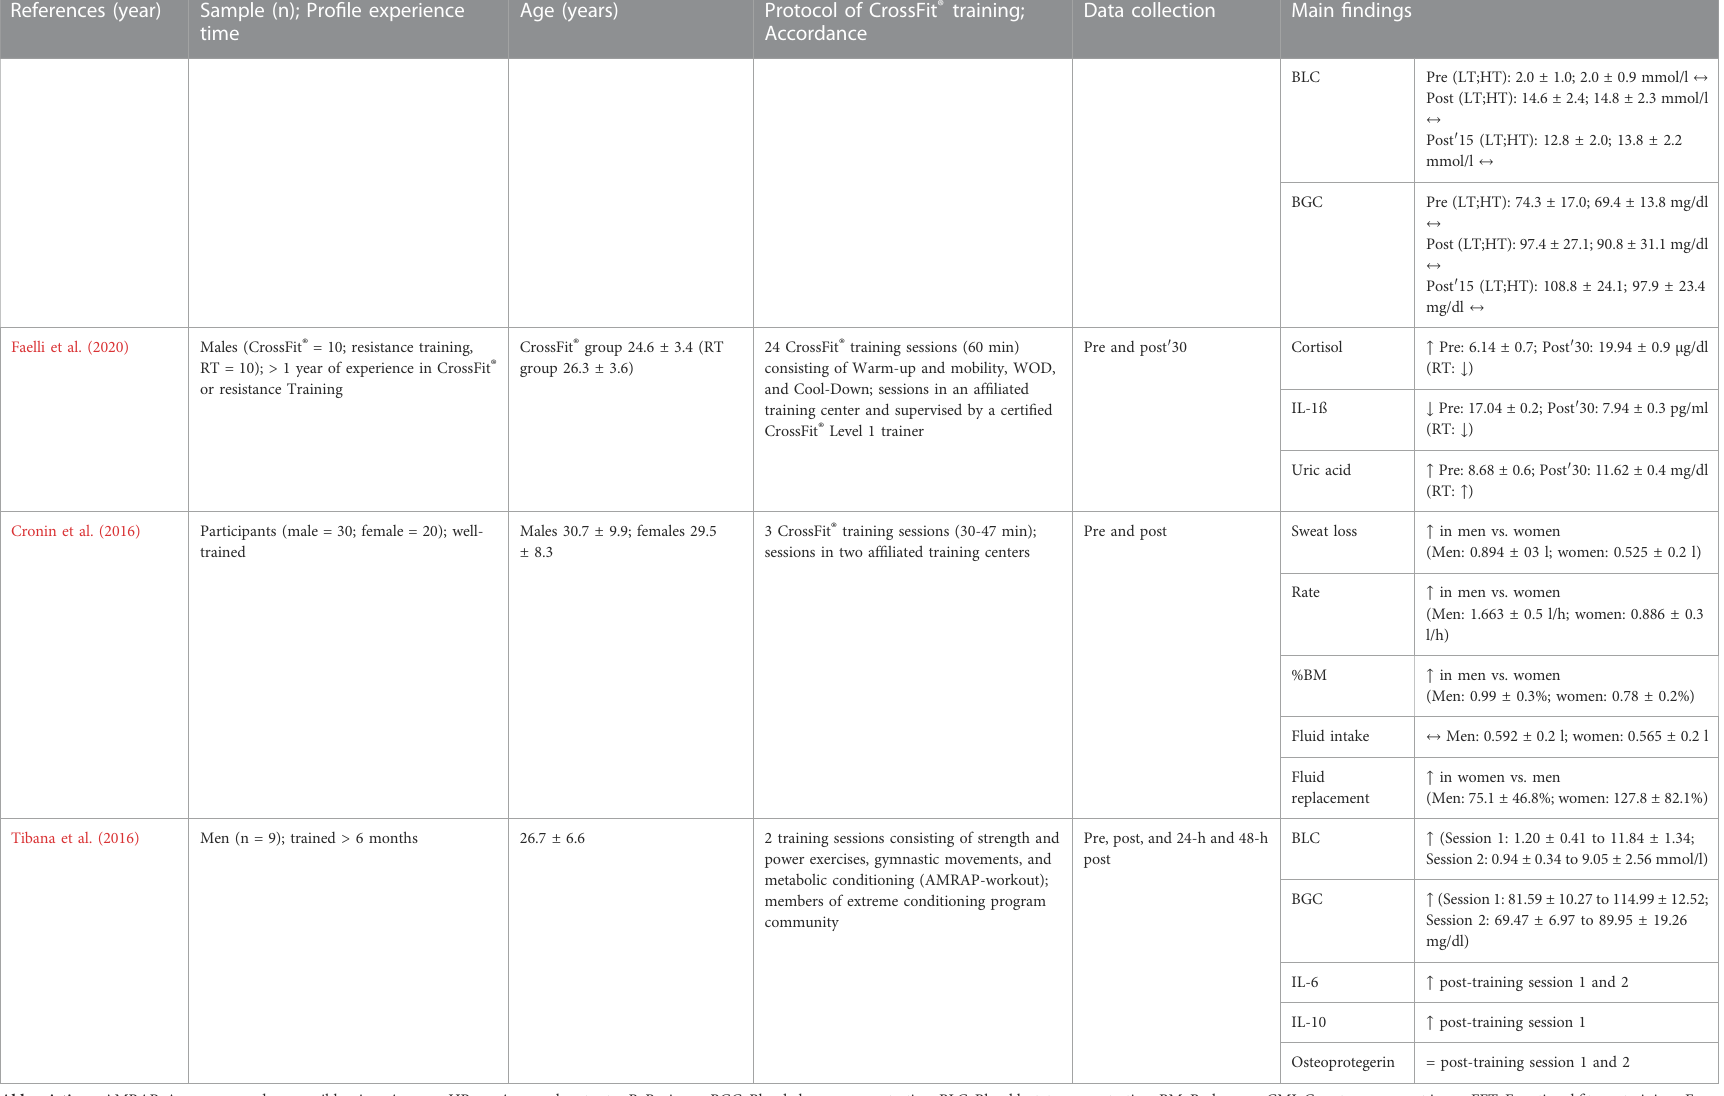
Abbreviations: AMRAP,As manyrounds as possible; Avg, Average; HRavg, Averageheart rate ; B, Beginner; BGC, Bloodglucoseconcentration; BLC,Blood lactate concentration; BM,Body mass; CMJ,Countermovement jump; FFT,Functional fi tnesstraining ; E, Experiencedathletes;HT,Higher-Traininggroup;IL,Interleukin;iF3,InternationalFunctionalFitnessFederation;LT,Lower-Traininggroup;HRmax,MaximalHeartrate;RPE,Ratingofperceivedexertion;RT,Resistancetraininggroup;TL,Trainingload;WOD, Workout of the